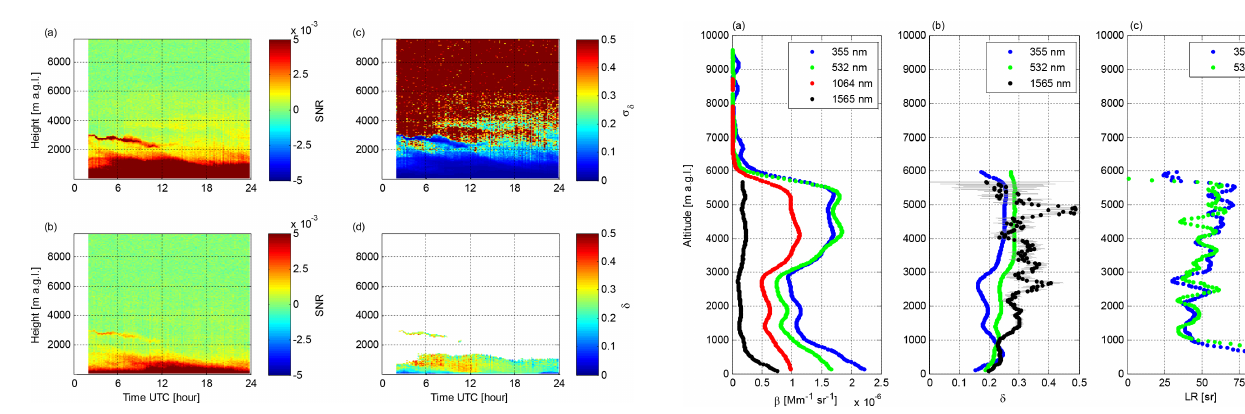
Figure 4. Limassol 21 April 2017 measurements with Halo Doppler lidar. (a) Time series of co-polar SNR at 300s integration time. (b) Time series of cross-polar SNR at 300s integration time. (c) Un- certainty in the depolarization ratio. (d) Particle linear depolariza- tion ratio filtered with σ δ < 0 . 05.